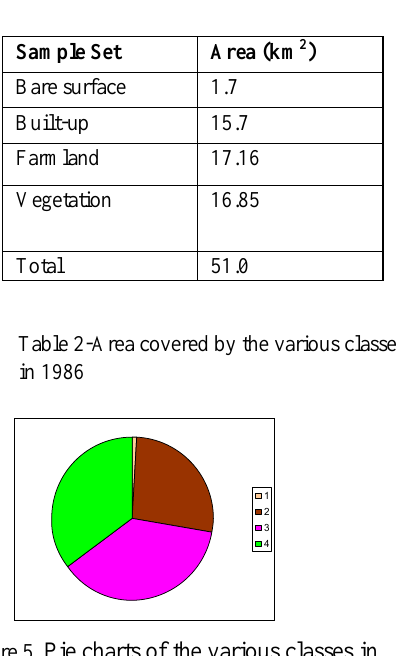
Figure 3b- Land use/Land cover map of study area for 1986